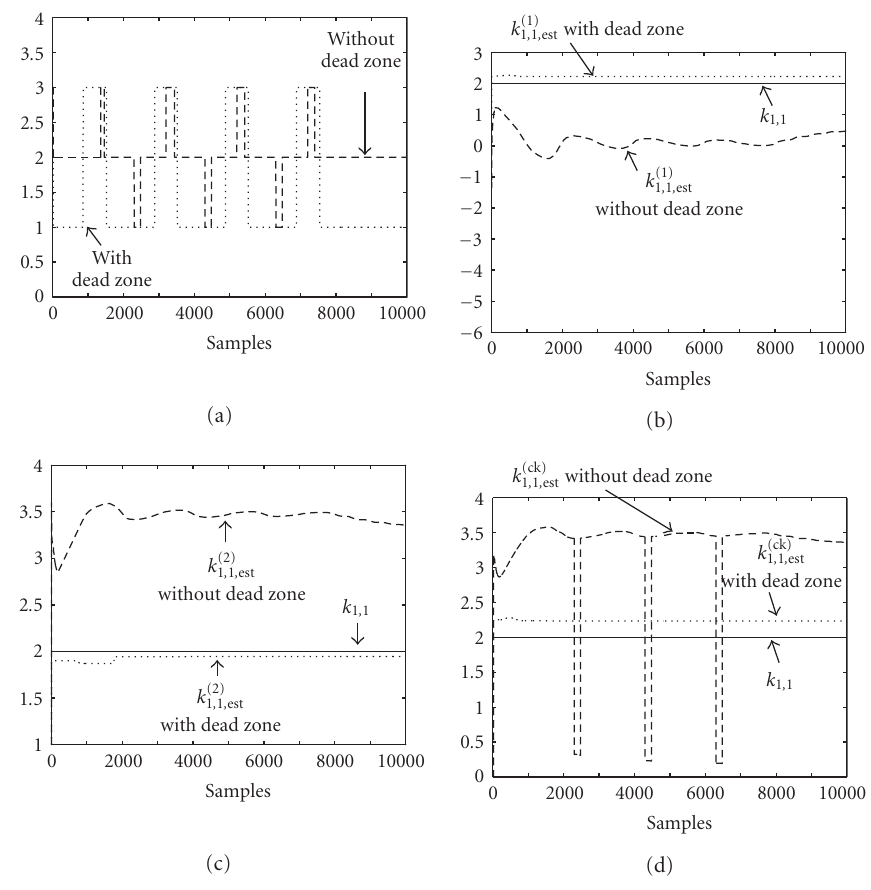
Figure 5.3. (a) Active estimator. (b) Estimated value of k (1) 1,1 . (c) Estimated value of k (2) 1,1 (d) Estimated value of k ( c k ) 1,1 using the multiestimation